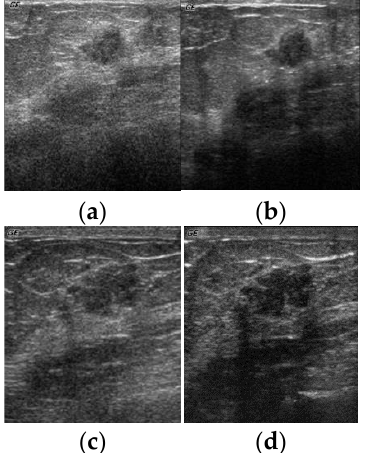
Figure 5. Ultrasound breast cyst image for four distinct settings of the parameters acquired from the same ultrasound sensing system (GELOGIQ 700). Breast cyst images acquired from ( a ) Parameter Setting-1, ( b ) Parameter Setting-2, ( c ) Parameter Setting-3, and ( d ) Parameter Setting-4. Table 11. The four distinct settings of the parameters in the ultrasound sensing system (GELOGIQ 700). Parameter Setting